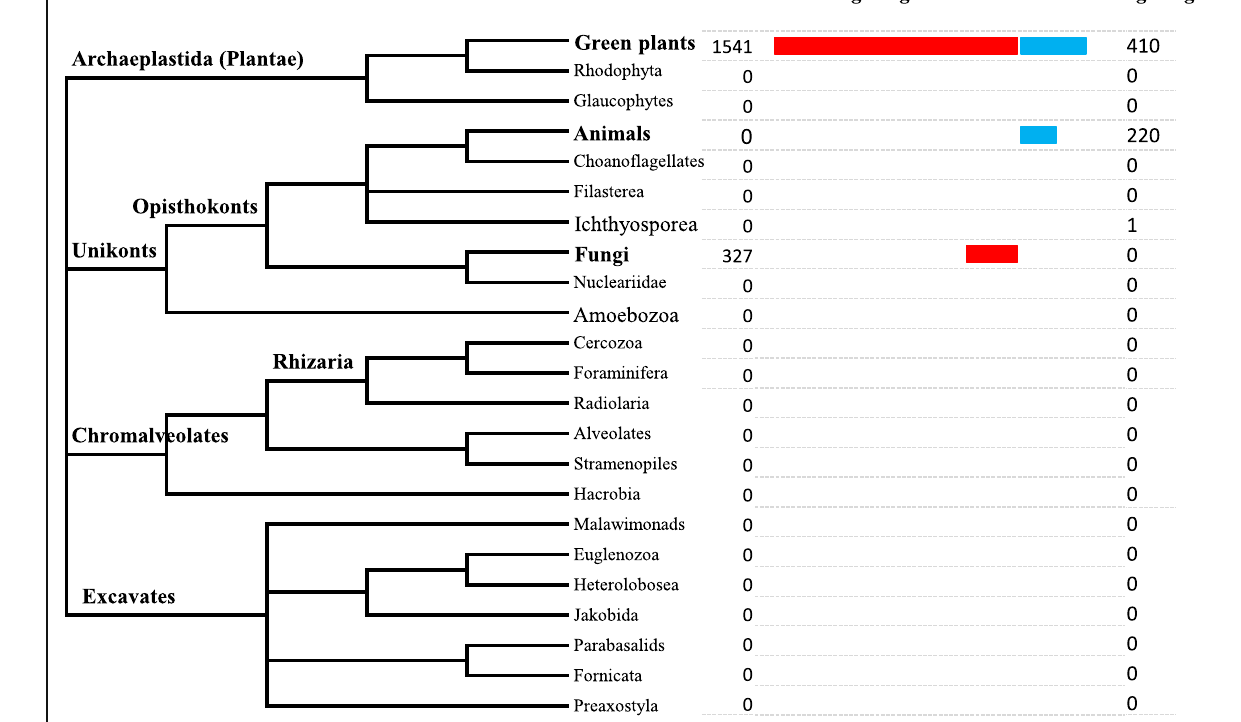
Fig. 1 The distribution of BPA and ACD11 homologous genes in the tree of life. The left panel depicts eukaryotic phylogenetic relationships based on the Tree of Life phylogeny (http://tolweb.org/). Lineages with bold fonts indicate the presence of BPA or ACD11 homologs. The right panel shows the numbers of BPA or ACD11 homologs identified in each